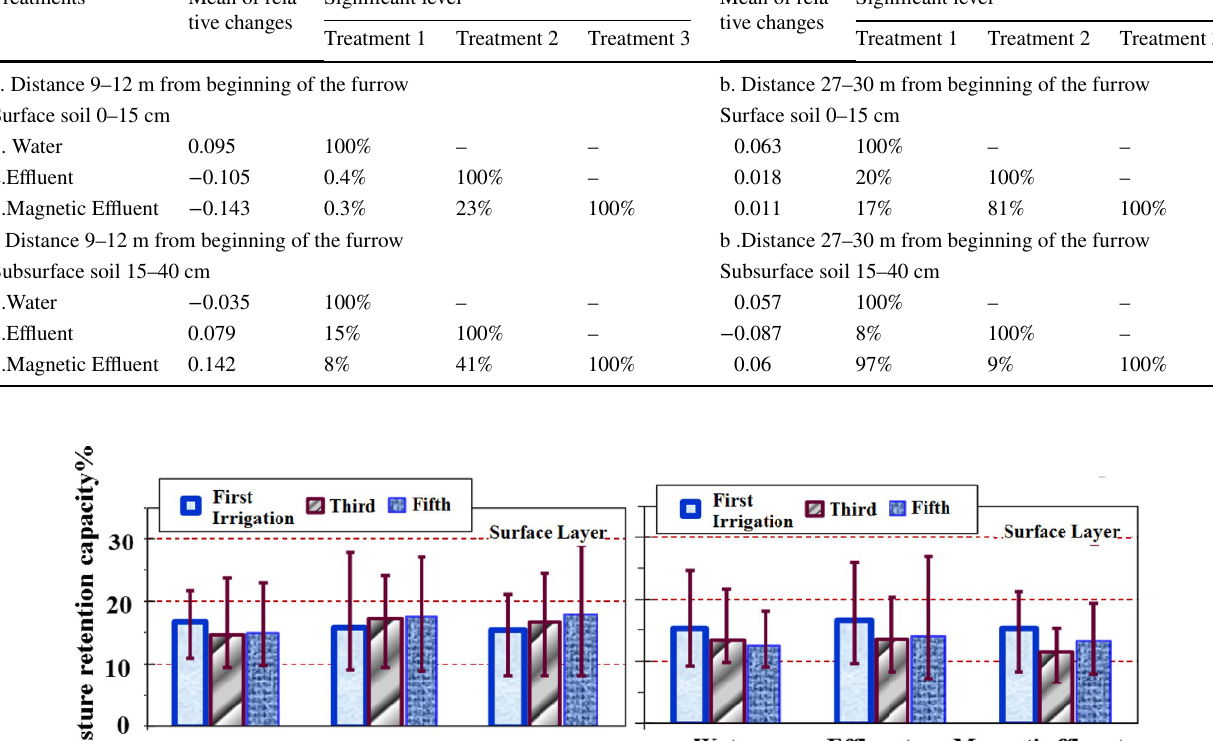
Table 4 Mean of "relative changes" and the level of significance of apparent-specific gravity of soil in different irrigation treatments Treatments